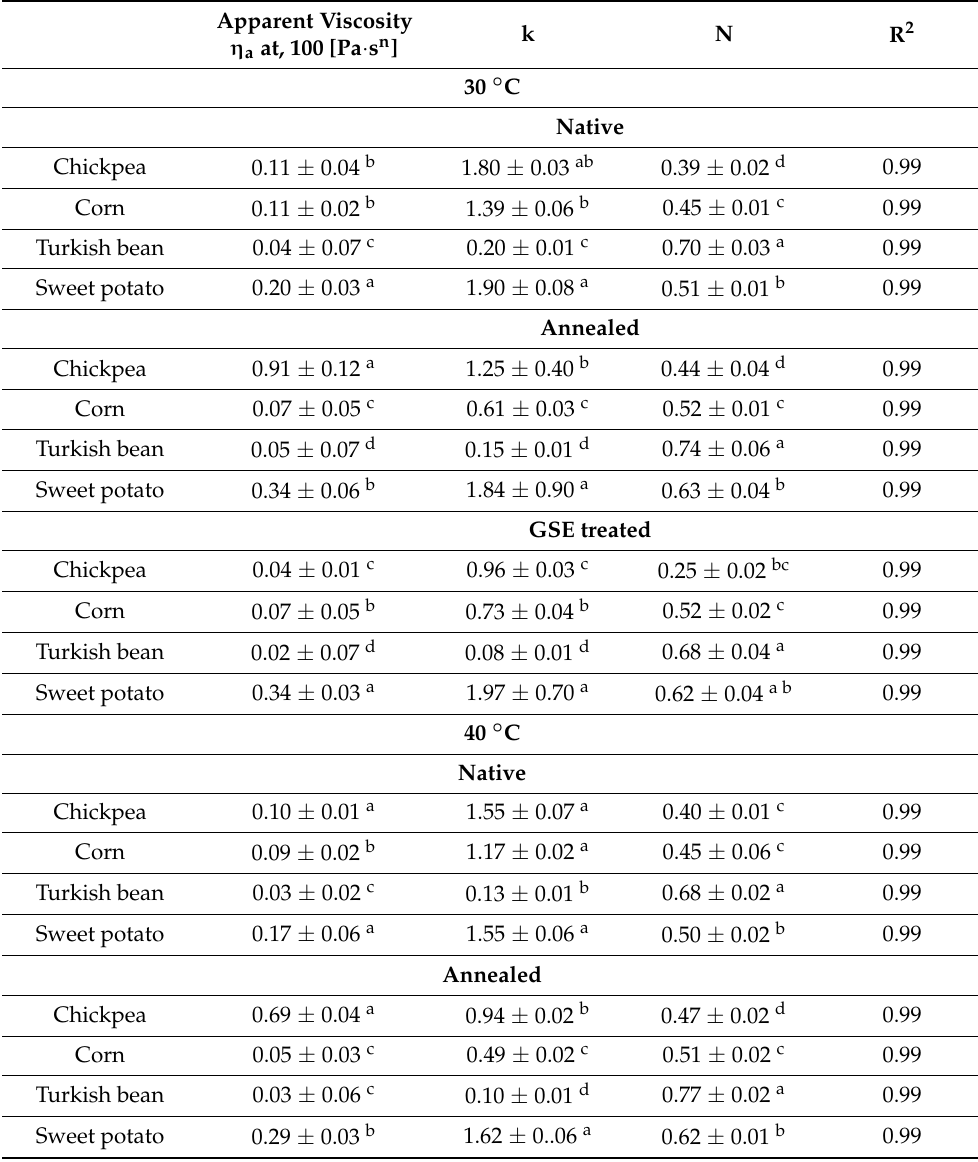
Table 1. Effect of temperature on power law model parameters (n, K ) and apparent viscosity of chickpea, corn, Turkish bean, and sweet potato starches tested at 30 and 40 ◦ C. Apparent